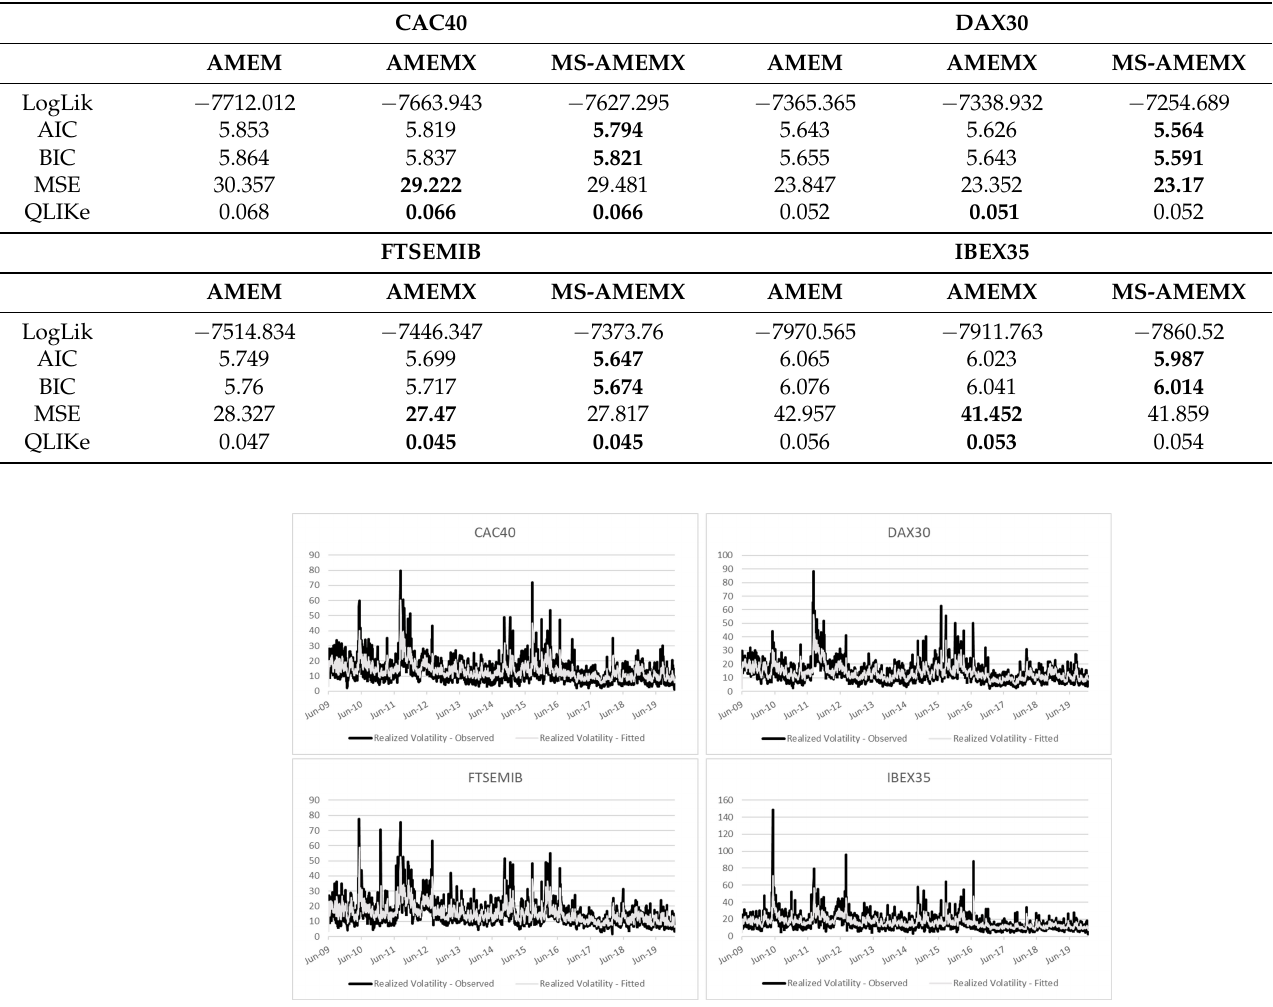
Figure 4. CAC40, DAX30, FTSEMIB and IBEX35 realized (black line) and fitted (gray line) volatility. Sample period: 1 June 2009 to 31 December